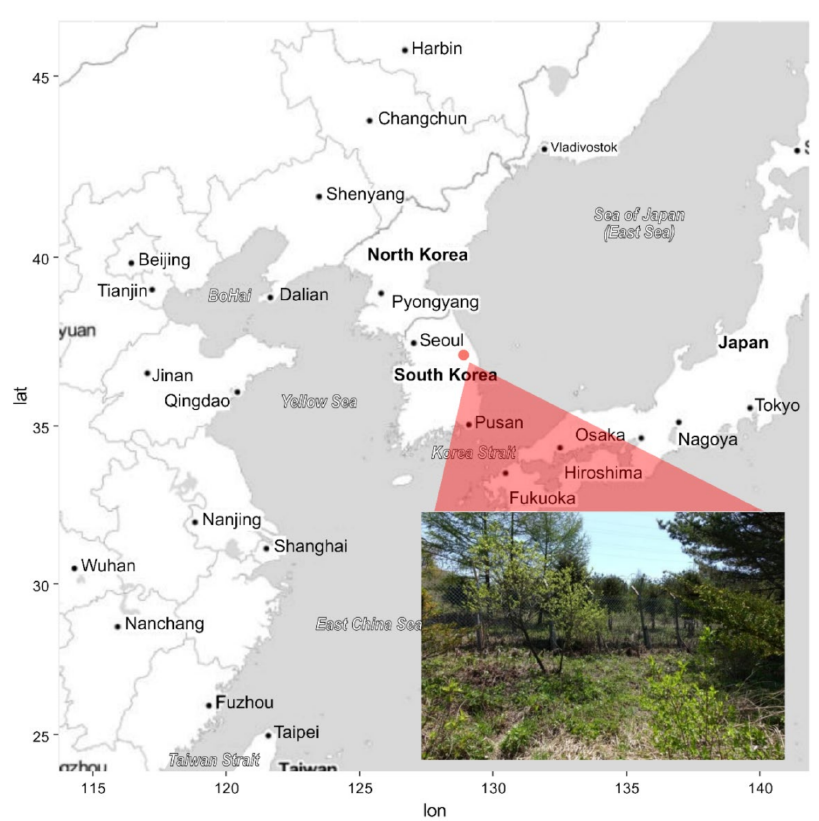
Figure 1. Habitat location of Cypripedium guttatum in the Republic of Korea. The red point is Manhangjae where C. guttatum is located. The photograph was taken within the artificial fence (lat = latitude, lon =